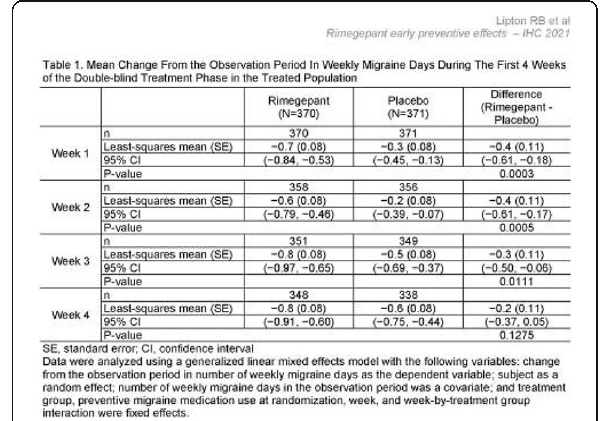
Table 1 (abstract AL053). See text for description